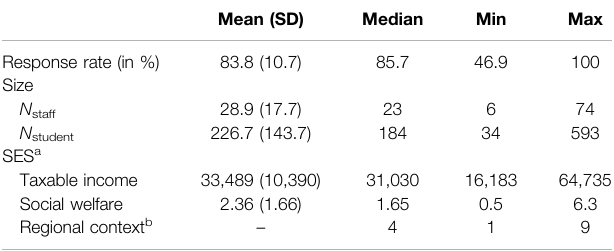
TABLE 1 | Descriptive statistics of the sampled primary schools ( N (cid:1)